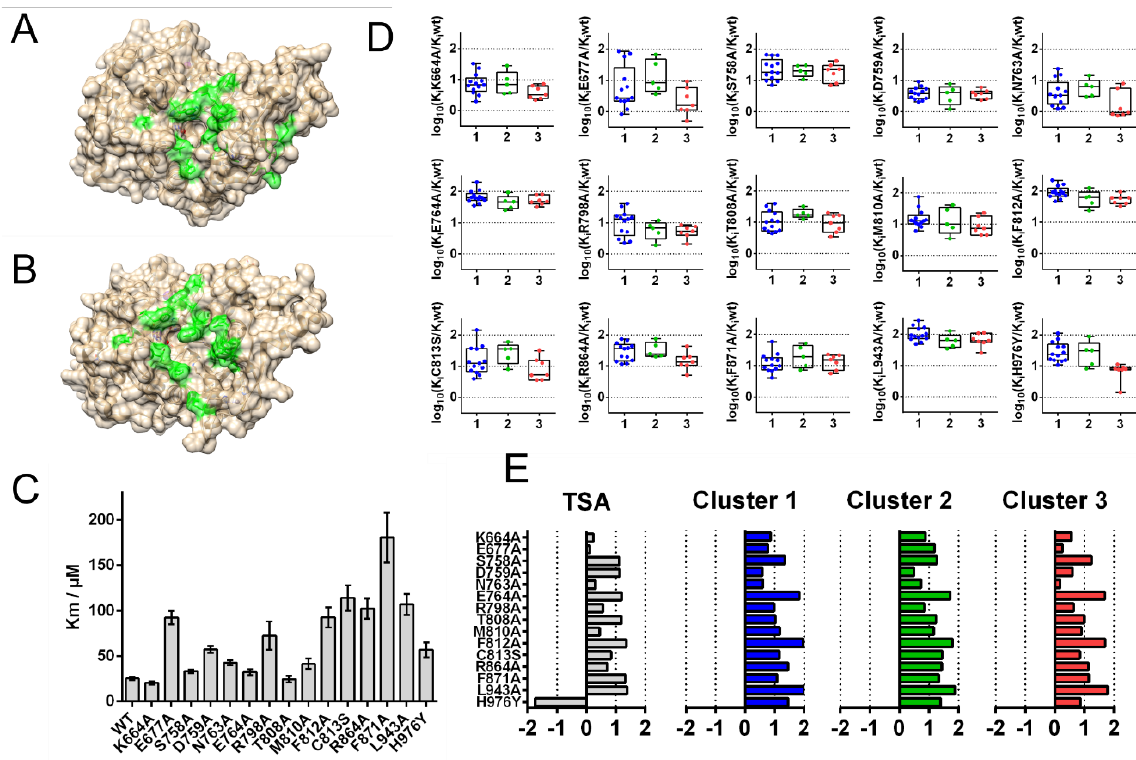
Figure 5. Overview of the mutational study. ( A , B ) are showing the substituted amino acid residues in green for the open ( A ) and closed ( B ) conformation. ( C ) K m values for the artificial substrate Boc-Lys{TFA}-AMC. ( D ) Box-Whisker-Plot showing the impact of amino acid substitution on the binding of TZD-ligands on cdHDAC4 wt . ( E ) Average impact of amino acid substitution for the three main TZD cluster in comparison to Trichostatin A (TSA).